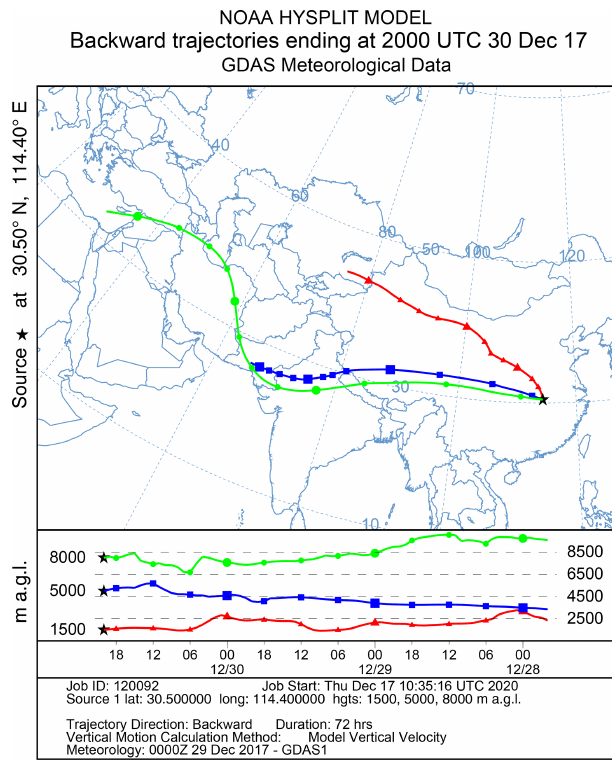
Figure 9. The 3d backward trajectories starting from Wuhan at 20:00UTC on 30 December 2017 (at 1.5, 5.0, and 8.0km) com- puted using the HYSPLIT model (Draxler and Rolph,